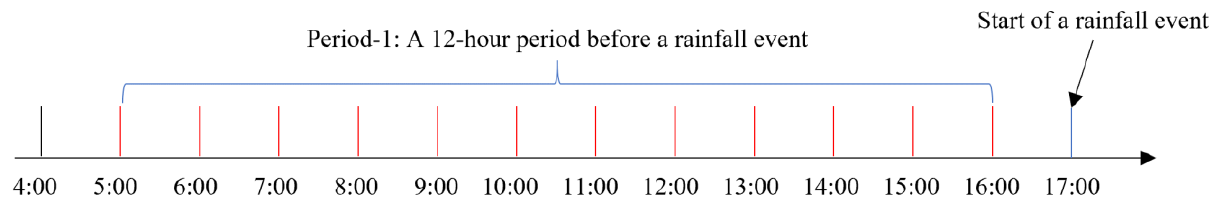
Figure 5. Using the 12-h period before a rainfall event to determine the prediction factor